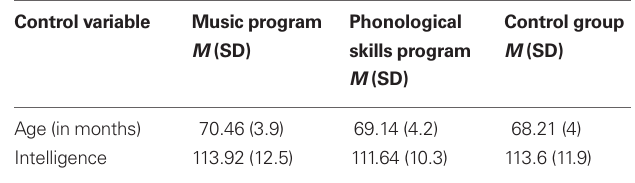
Table 1 | Mean and SD for the control variables age and intelligence